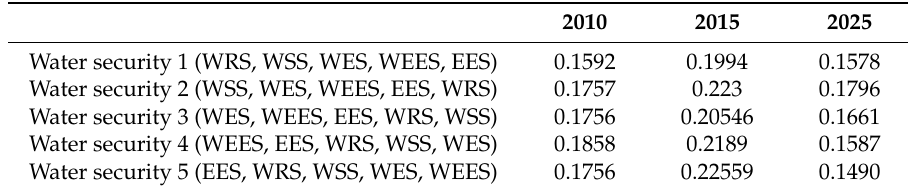
Table 6. Sensitivity analysis